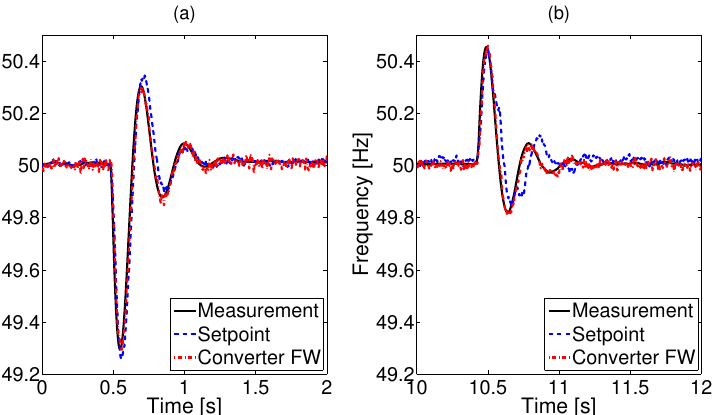
Figure 13. Comparison of the measured, calculated and emulated output frequency of the syn- chronous generator during active-reactive load switched on ( a ) and off ( b